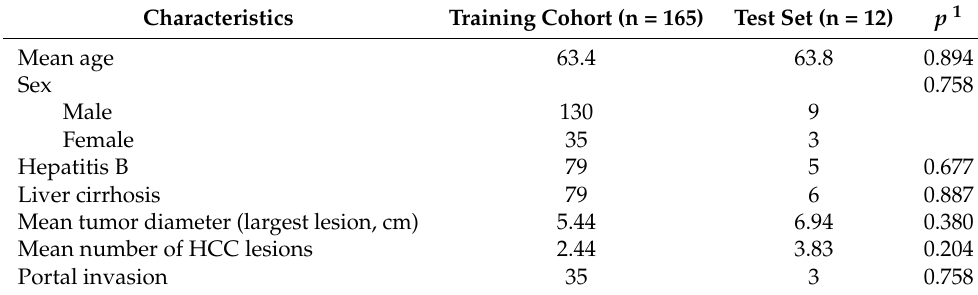
Table 1. Demographics and characteristics of 177 HCC cases in training and test sets.